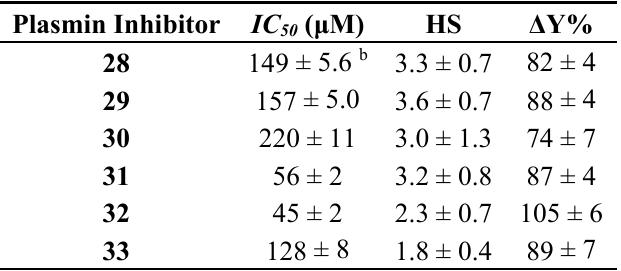
Figure 3. Representative profiles of direct inhibition of human plasmin by sulfated molecules. The inhibition of plasmin was measured spectrophotometrically through a chromogenic substrate hydrolysis assay at pH 7.4 and 37 °C. Solid lines represent sigmoidal fits to the data to obtain IC 50 , HS, Y M , and Y O using Equation (1), as described in the Experimental Procedures. Table 1. Plasmin inhibition by sulfated small molecules.